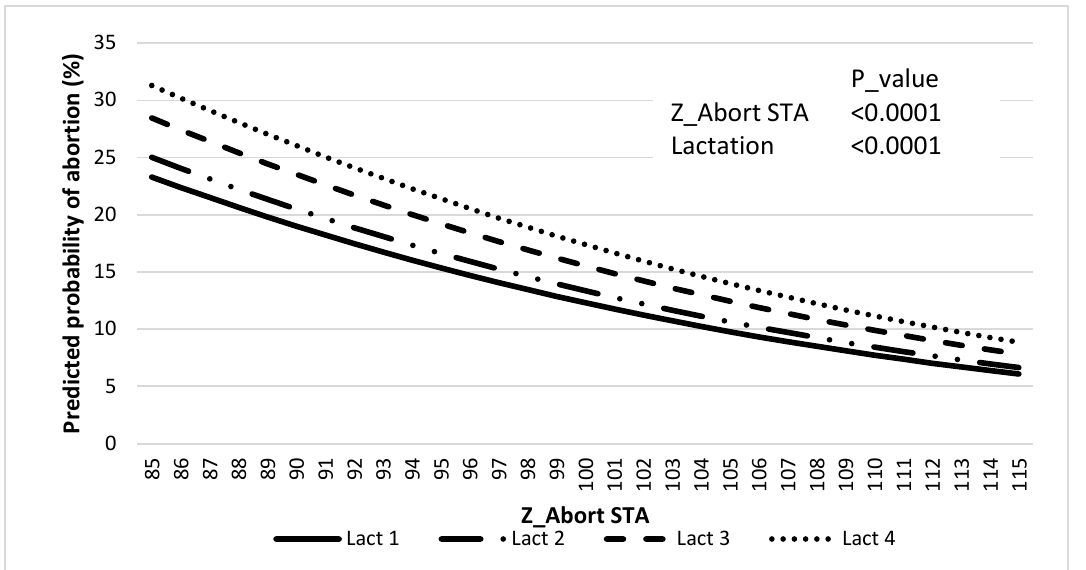
Figure 3. Association between predicted probability of abortion and Z_Abort STAs for lactations 1 to 4.